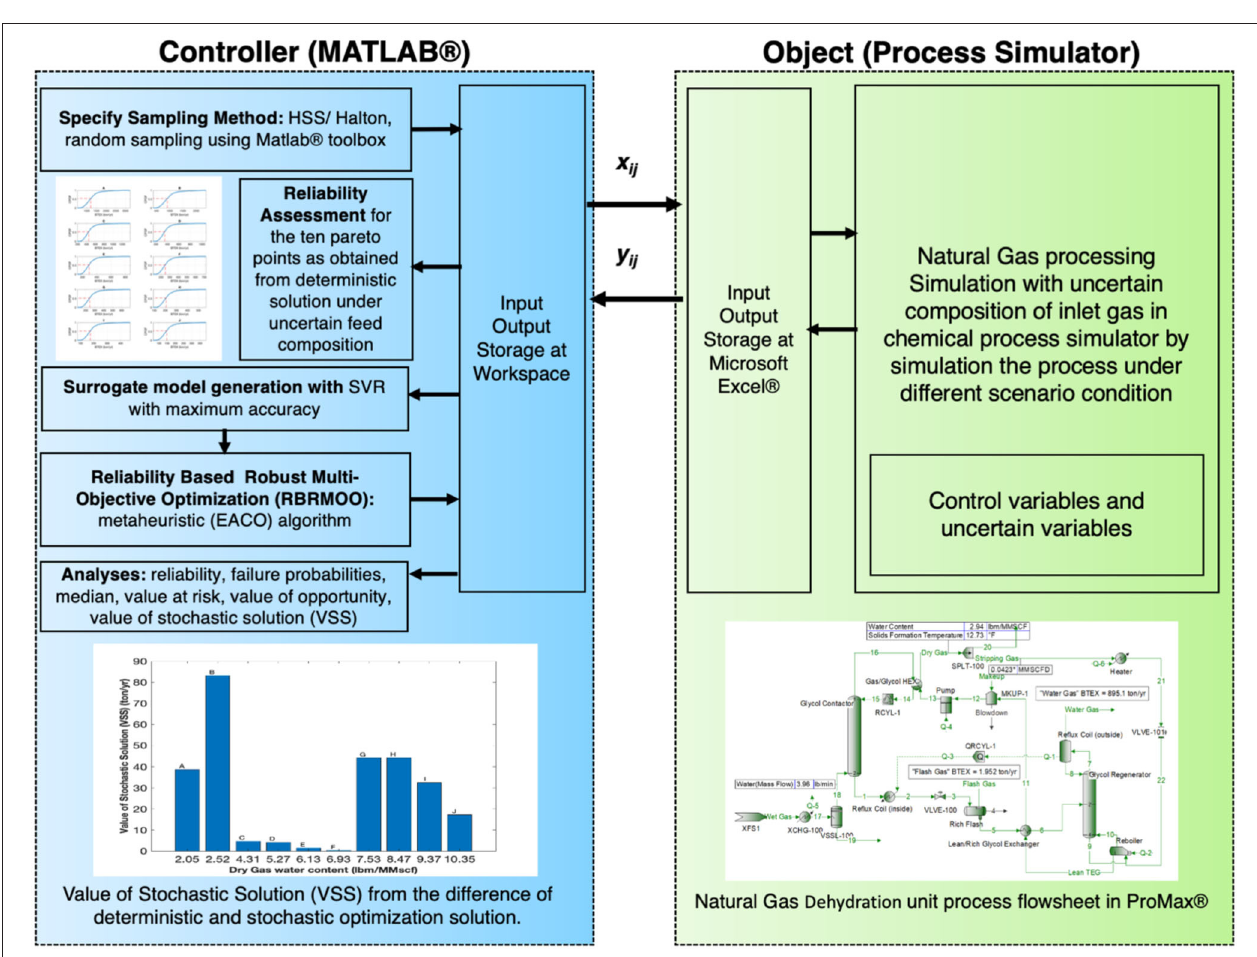
FIGURE 2 | Framework for random variable generation, process simulation, data-based metamodeling, reliability estimation, reliability based robust multi-objective optimization, and value of stochastic solution estimation of natural gas dehydration process.